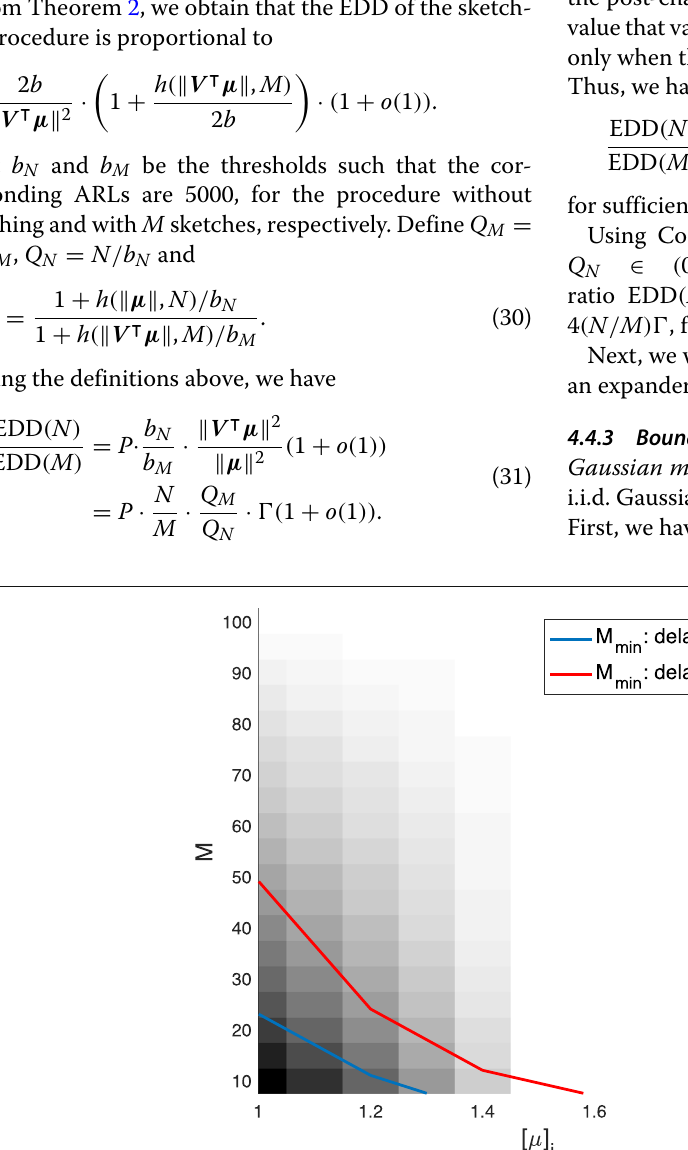
Fig. 3 The P factor defined in (30) for different M and [ μ ] i , when the post-change mean vector has entries all equal to [ μ ] i . Assume N = 100. The white regions correspond to P ≥ 1, and dark regions correspond to P < 1 and the darker, the smaller P is (note that the smallest P in this graph is above 0.75). We also plot the M min (defined later in (35)) required in these cases such that the EDD of the sketching procedure is no more than δ larger than the corresponding procedure without sketching (fixing ARL = 5000), for δ = 1 and δ = 0.5. The M min are obtained by Monte Carlo simulation. The M min versus [ μ ] i correspond to the blue and the red curves, respectively. Above these two curves, the EDD with sketching is almost thesame as before (without sketching), i.e., the regime where sketchinghaslittleloss . The left-bottom corner corresponds to the region where sketching has more loss. This also shows that indeed P < 1 is an indicator of significant performance loss using